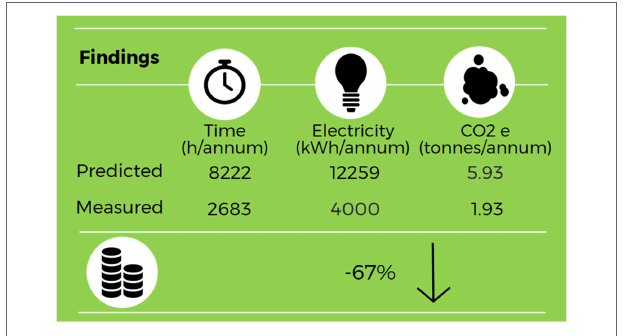
FigUre 8 | Maths 1 CO 2 e and electricity consumption analysis.